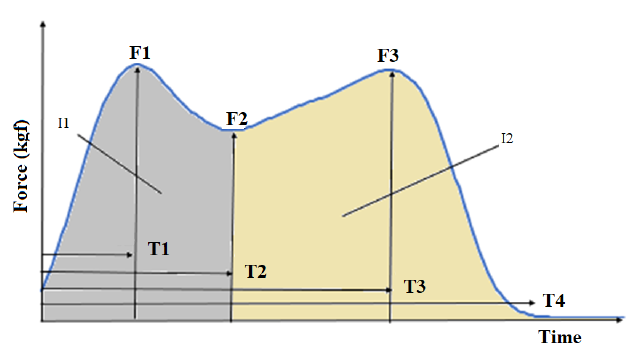
Figure A1. Identification of each of the variables used for statistical verification. Legend: I1: impulse during load absortion; F1: peak force of loading response; F2: low force of midstance; F3: peak force of push-off (impulsion); T1: time into loading response; T2: time into midstance; T3: time into impulsion; T4: total time to stance